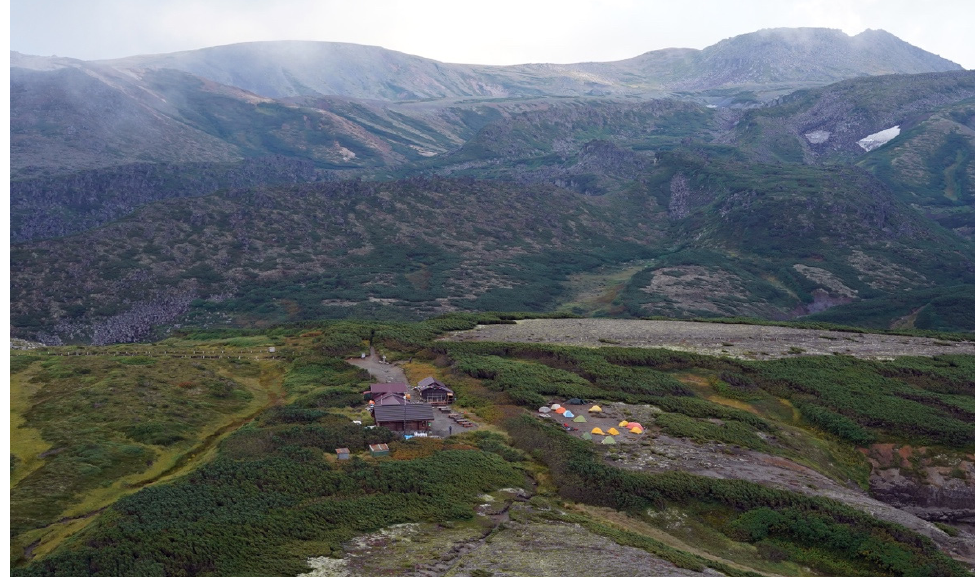
Figure 2. Photo of the Kuro-dake campsite with tents set-up (taken by the authors on 1 September 2019).